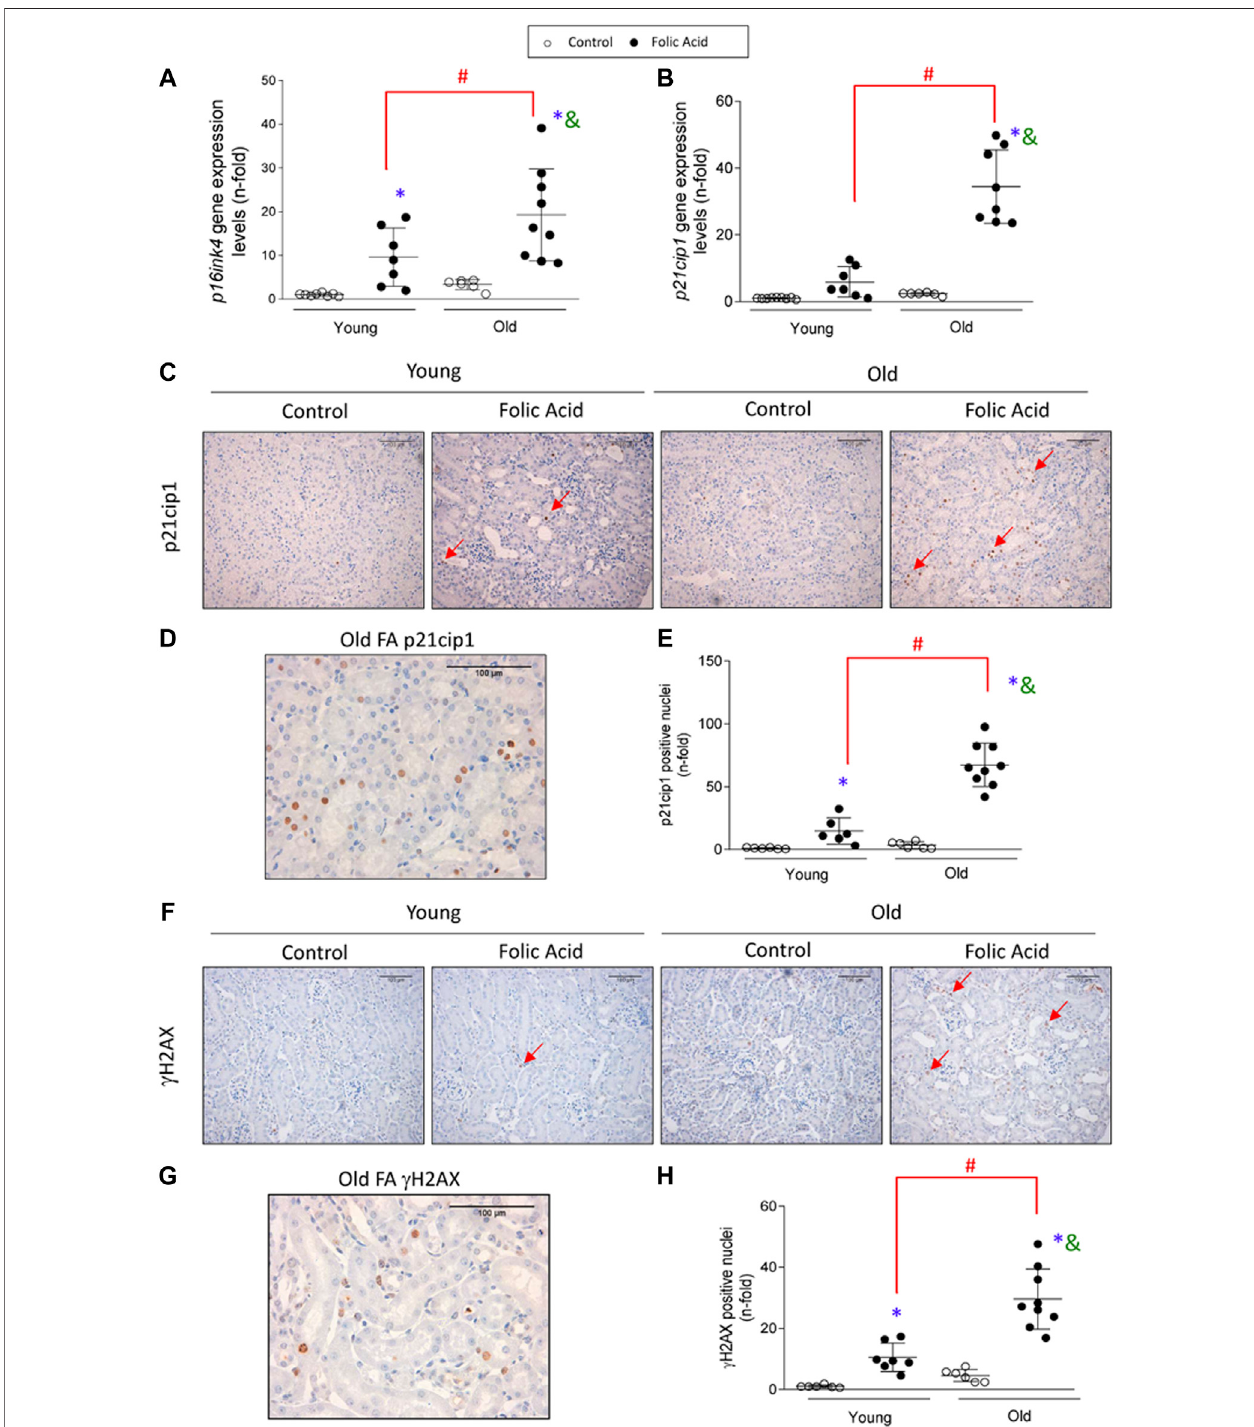
FIGURE 7 | Kidneyexpressionofcell-cyclearrestandDDRmarkerspathwayintheacutephaseoffolicacid(FA)nephropathyinoldandyoungmice.FolicAcid(FA;125 mg/kg) wasinjectedin3-months-old(Young)and1-year-old(Old)C57BL/6miceandkidneyswerestudiedafter48 h (A,B) Kidney p16ink4a (A) and p21cip1 (B) geneexpressionlevels. (C – E) p21cip1 immunohistochemistry was conducted. (C) Representative microphotographs of p21cip1 showing nuclear staining and (D) detail of a FA-injured old mouse kidney showing positivenuclearp21cip1staining. (E) Nuclearp21cip1quanti fi cation. (F – H) γ H2AXimmunohistochemistrywasperformed. (F) Representativemicrographsof γ H2AXand (G) detail ofaFA-injuredoldmousekidneyshowingpositivenuclear γ H2AXstaining. (H) Nuclear γ H2AXquanti fi cation.Redarrowsindicatepositivenuclearstaining.ScaleBars (cid:2) 100 μ m.Dataare expressedasmean ± SDof n (cid:2) 6 – 9animalspergroup.* p < 0.05vs.controlyoungmice, # p < 0.05vs.FA-injectedyoungmice, & p < 0.05vs.controloldmice.Theparametricone-way ANOVA statistical test was performed, except for γ H2AX quanti fi cation, in which a non-parametric Kruskal-Wallis statistical test was conducted.